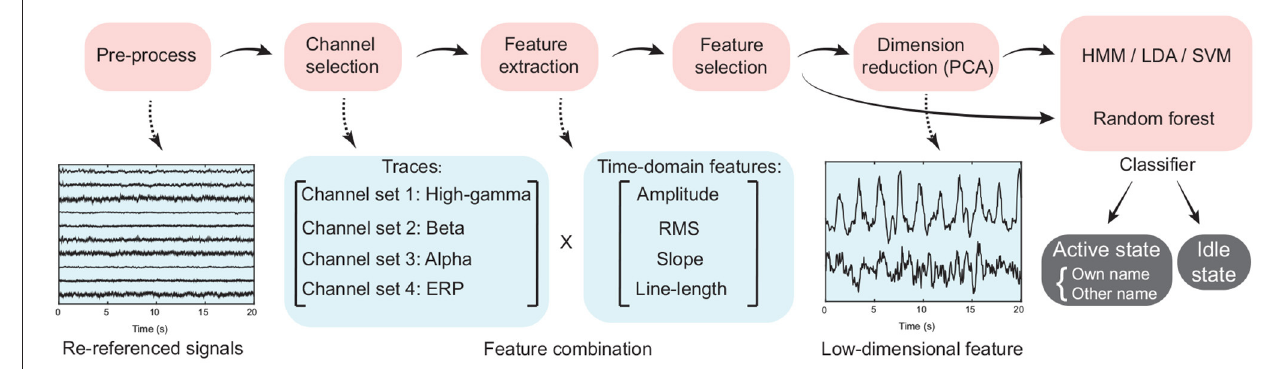
FIGURE 4 | The flow chart of signal processing and classification procedure. Time-domain features, including the average amplitude, root mean square, slope of linear regression, and line-length were extracted from the high-gamma, beta, and alpha band power traces, as well as the event-related potential.